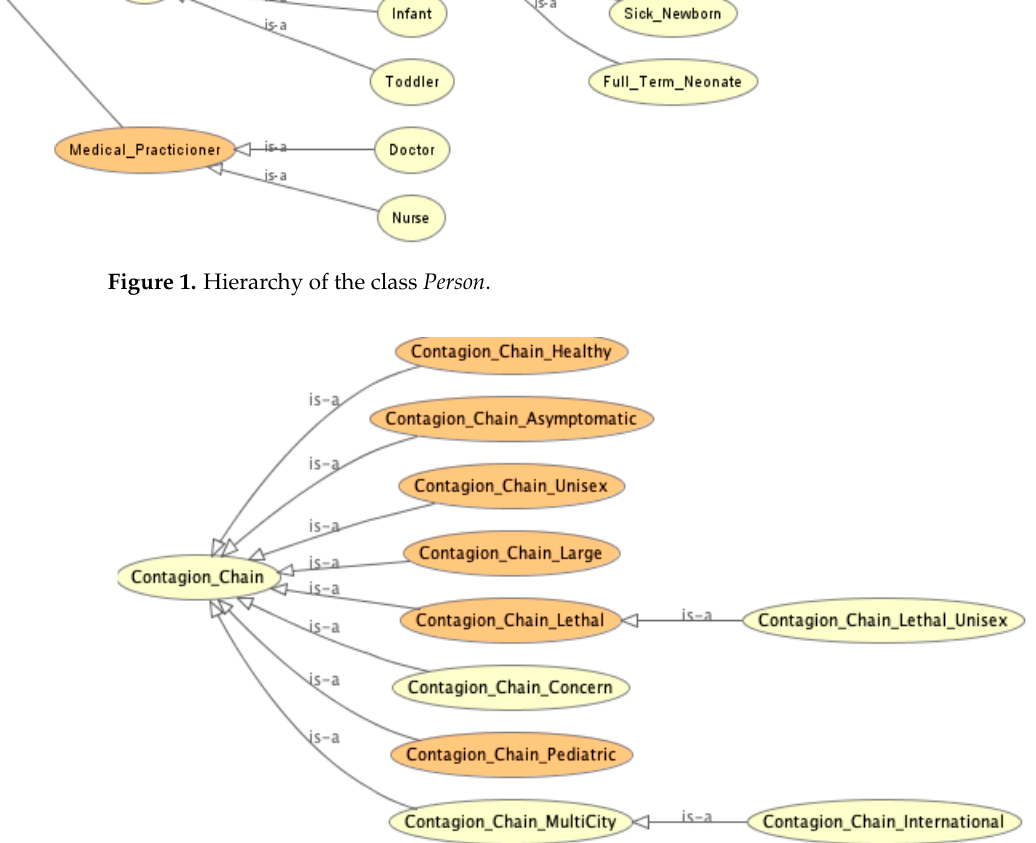
Figure 2. Hierarchy of the class Contagion_Chain. Step 5: Define properties.